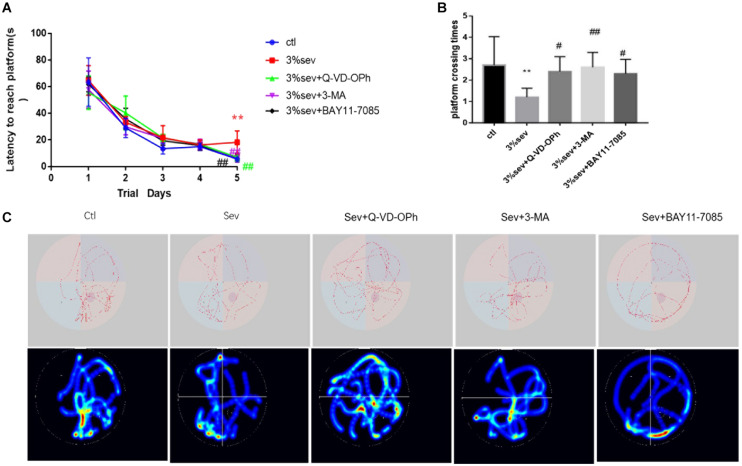
Sevoflurane reduced short-term cognitive deficiency via NF-κB/P65/autophagy/apoptosis regulation. (A) Escape latency in place trials evaluated the acquisition of spatial information. (B) Platform crossing times in probe test evaluated the memory retention ability. (C) Representative traces and graphical search patterns during MWM tests. Values are presented as mean ± SD; two-way repeated ANOVA followed by Dunnett’s multiple comparisons tests was used for escape latency. **P < 0.01 compared with the control group, #P < 0.05 compared with sevoflurane group, ##P < 0.01 compared with sevoflurane group.